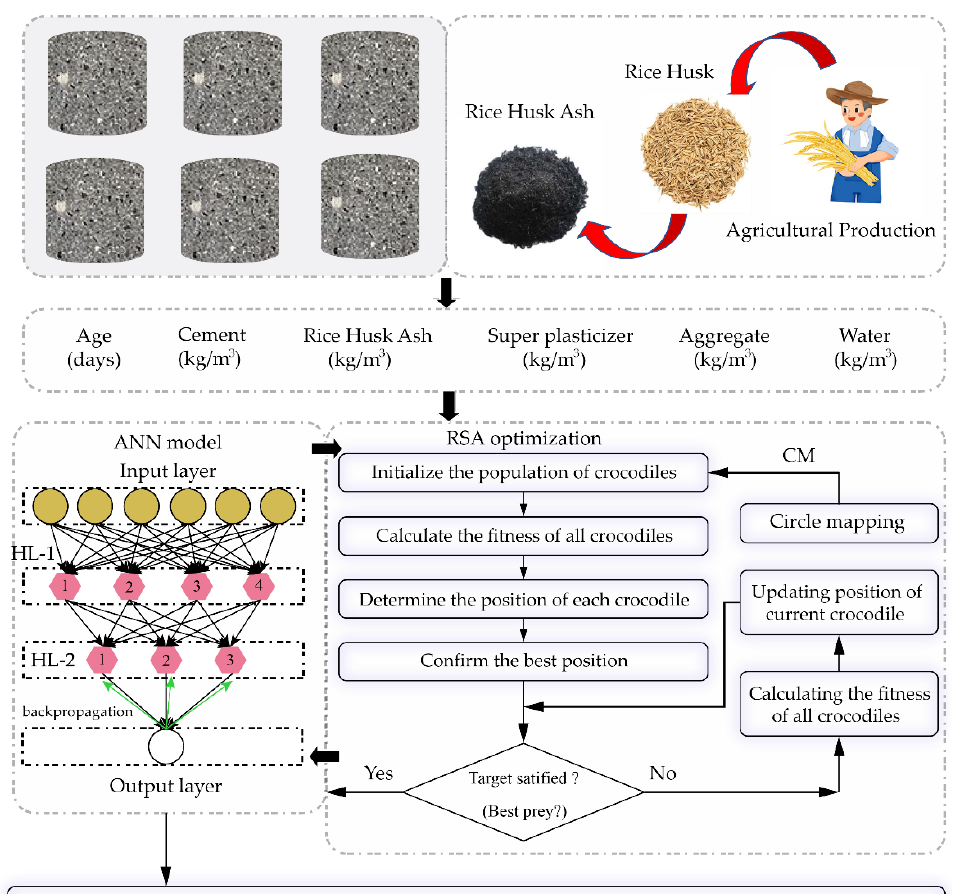
Figure 2. Flowchart of generating CMRSA–ANN model to predict the compressive strength of RHA concrete.